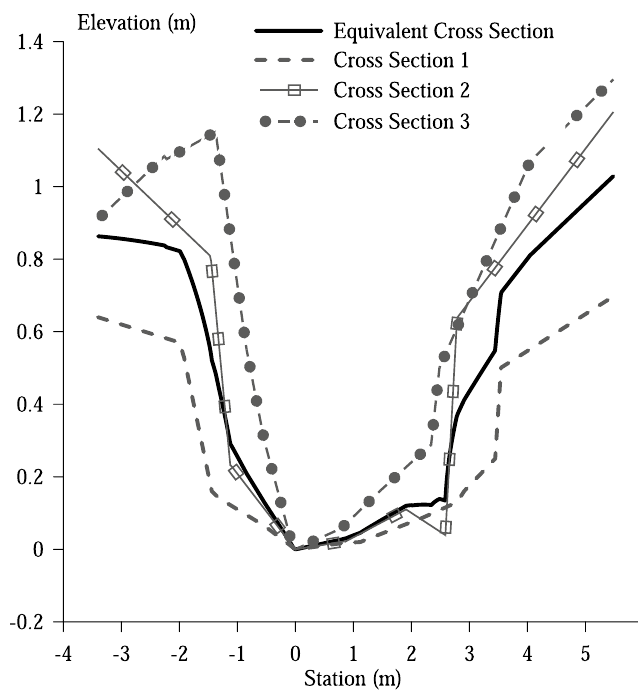
Fig. 4 Cross sections in Step‑pool and equivalent cross